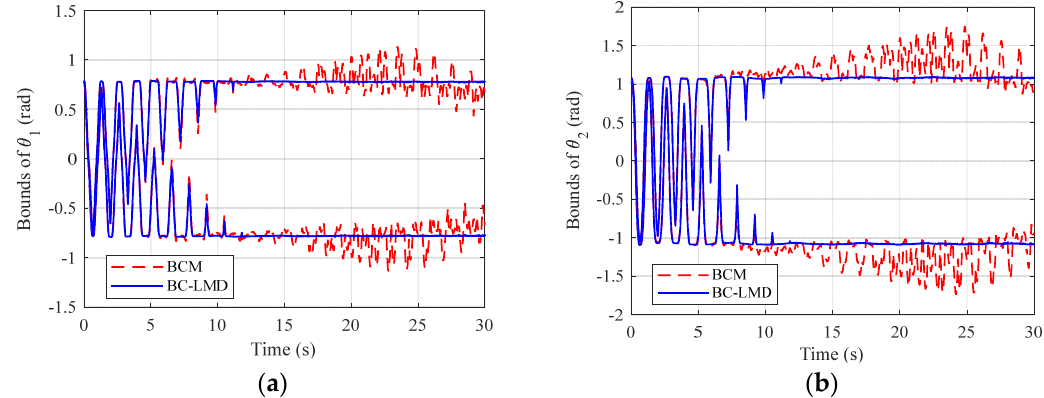
Figure 13. Bounds of the double pendulum under a 10% uncertainty level: ( a ) bounds of the rotation angle of the top rod; ( b ) bounds of the rotation angle of the bottom rod.